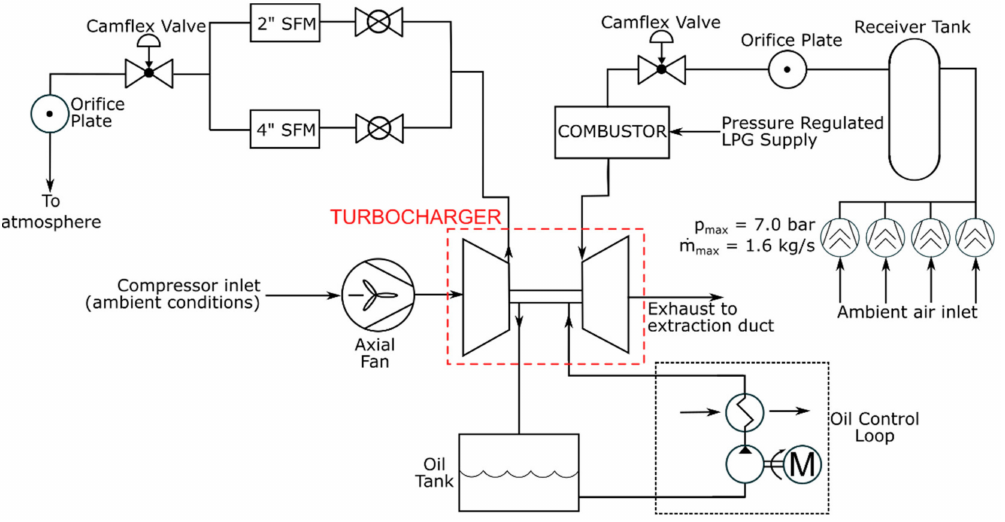
Figure 9. Schematic of QUB turbocharger test